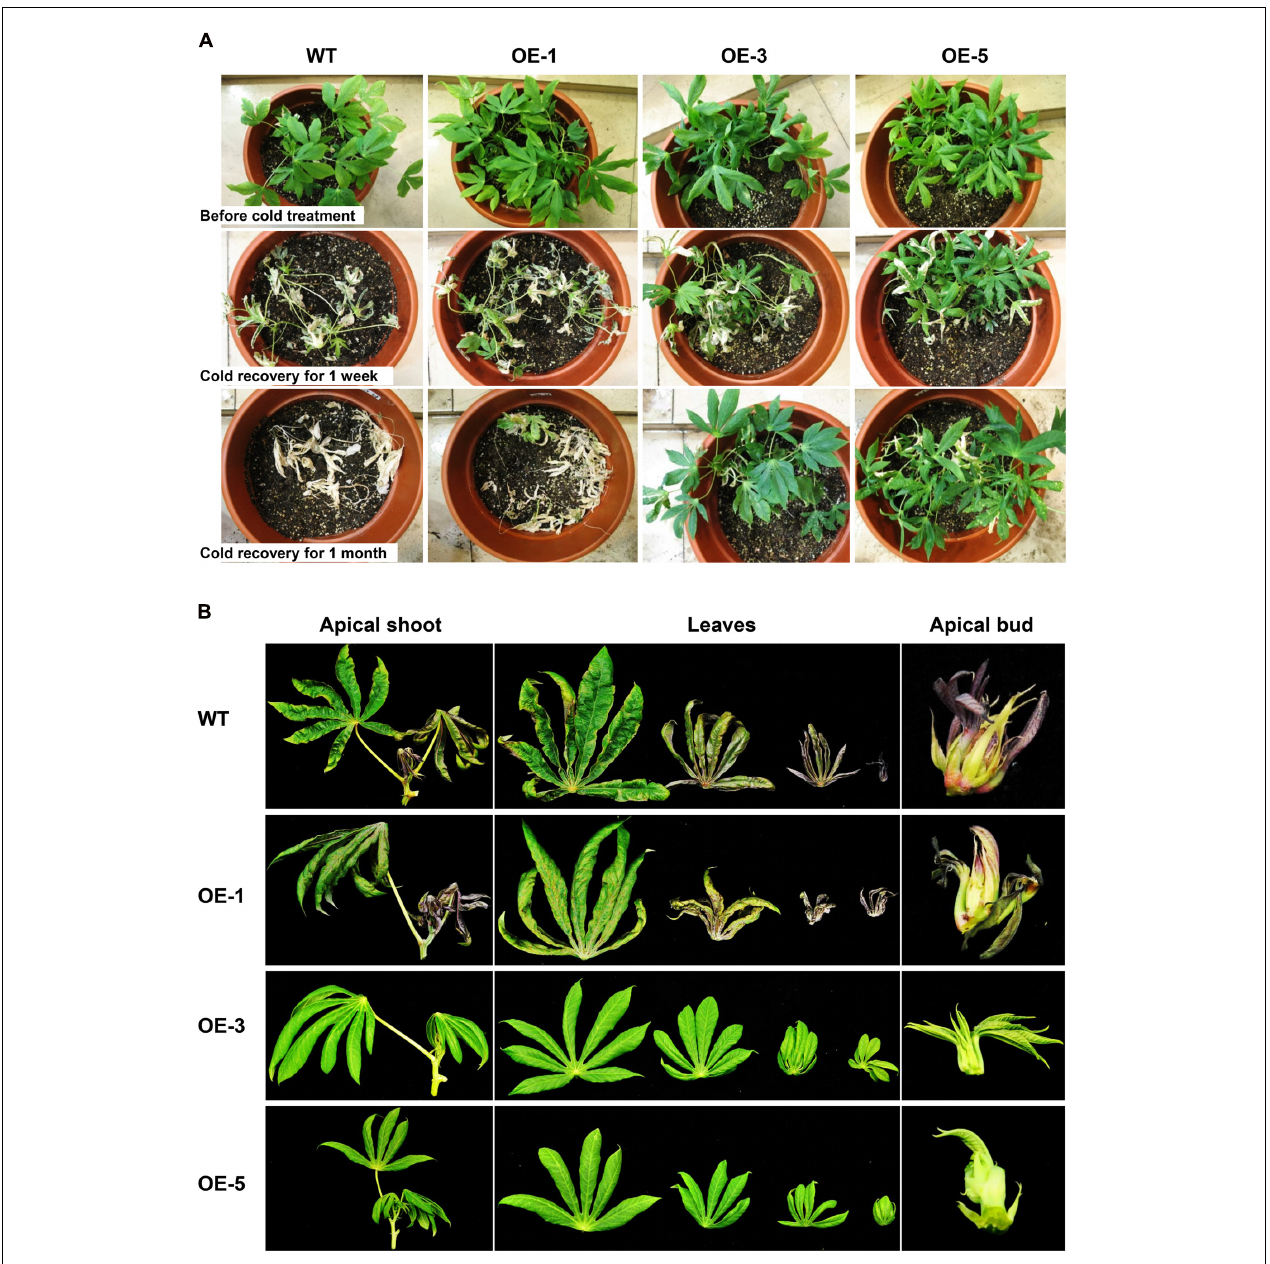
FIGURE 3 | Performance of Arabidopsis CBF3 overexpressing cassava in response to low temperature. (A) Pot-grown plants in the greenhouse before and after cold treatment (0 ◦ C, 24 h) for 1 week and 1 month recovery under normal growth condition. (B) Apical shoots, leaves, and apical buds harvested from WT and OE transgenic plants in the field under chilling condition in early